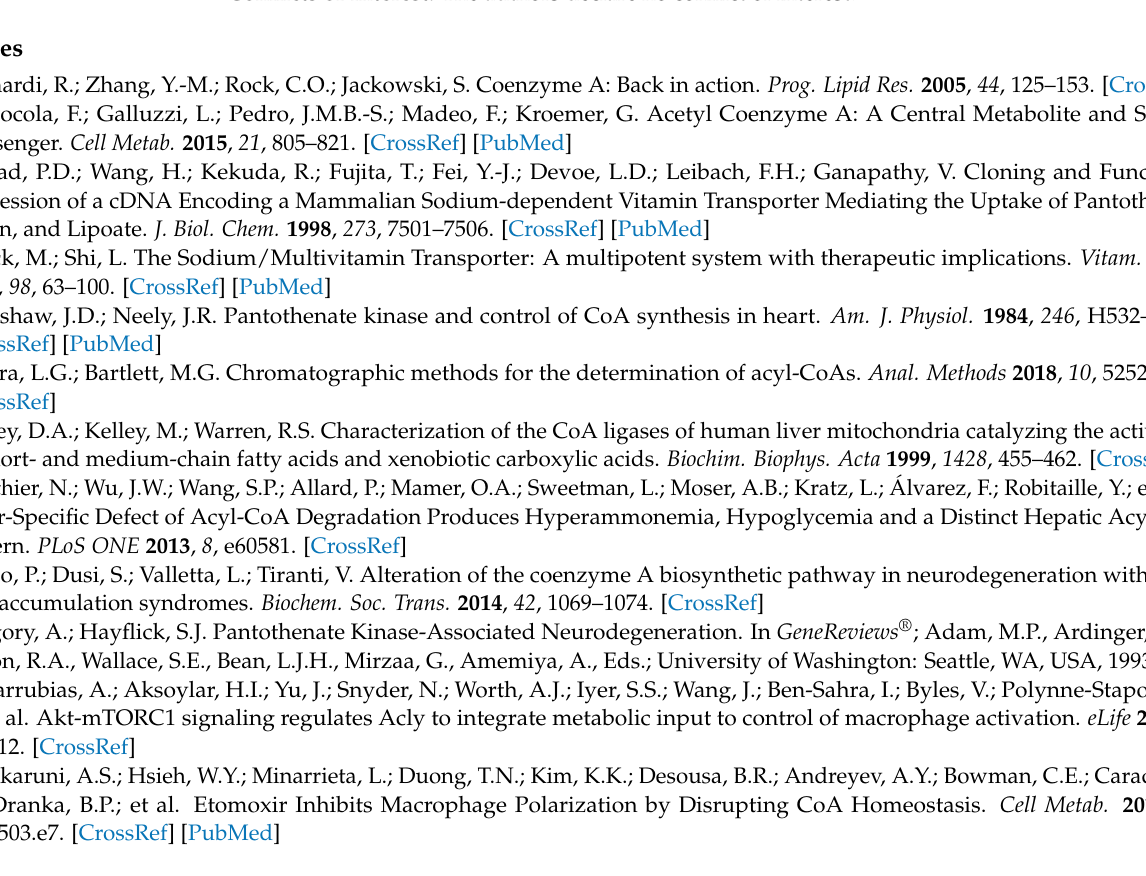
Figure S2. Pantothenate is only detectable with adequate sensitivity with negativemode MRM, Figure S3. Free CoA is produced in the ESI source from acetyl, propionyl, and isovaleryl CoA, Figure S4. Endogenous crotonoyl CoA concentrations, Table S1. Mass spectrometry parameters for detection of short-chain acyl CoAs, dephospho-CoA, and pantothenate, Table S2. Determination of matrix